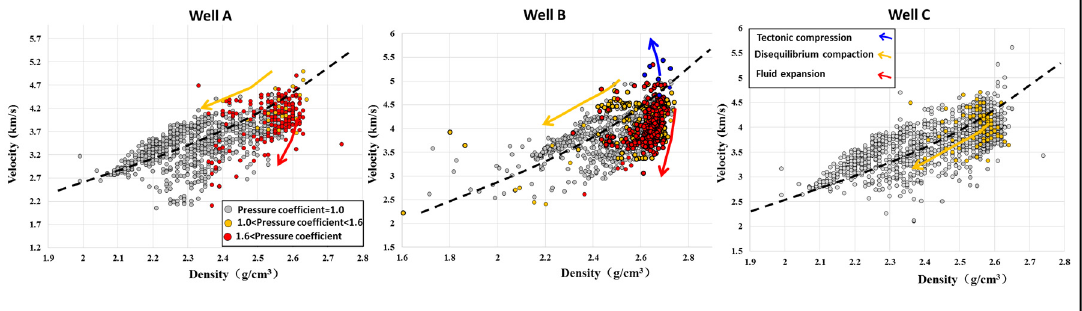
Figure 9. Vertical effective stress plotted against the velocity and density, covering units of age from Oligocene to Eocene and depth from 2400 m to 5100 m. Gray circles represent shales with normal pressure. Yellow and red circles represent overpressure shale. Overpressure data of Well A lie on the loading curve. Overpressure data of Wells B and C lie on the unloading curve. Table 1. Mechanisms of overpressure in a different stage.